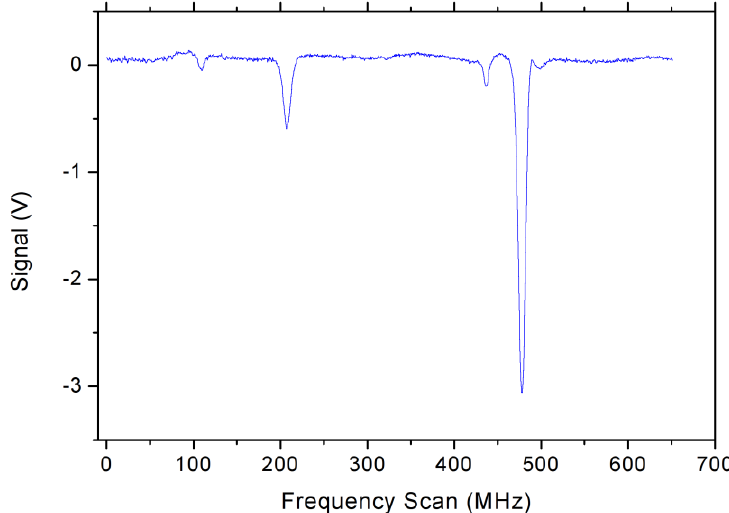
Figure 4. WMS acquisition of the absorption profile, at the same methanol vapor pressure of 0.4 mbar, taken with a modulation amplitude of 10 mV most intense line is about 9 MHz